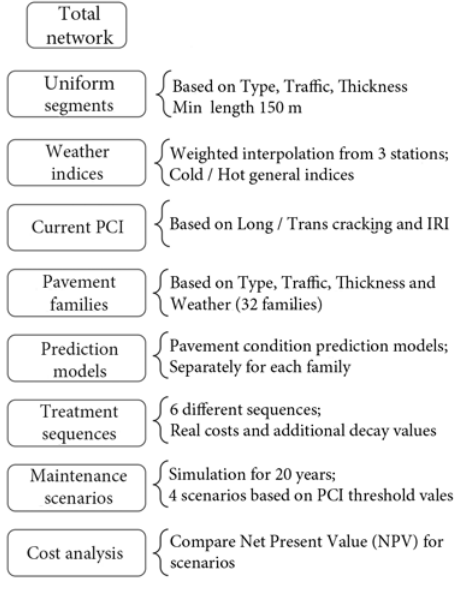
Fig. 2. Study flowchart